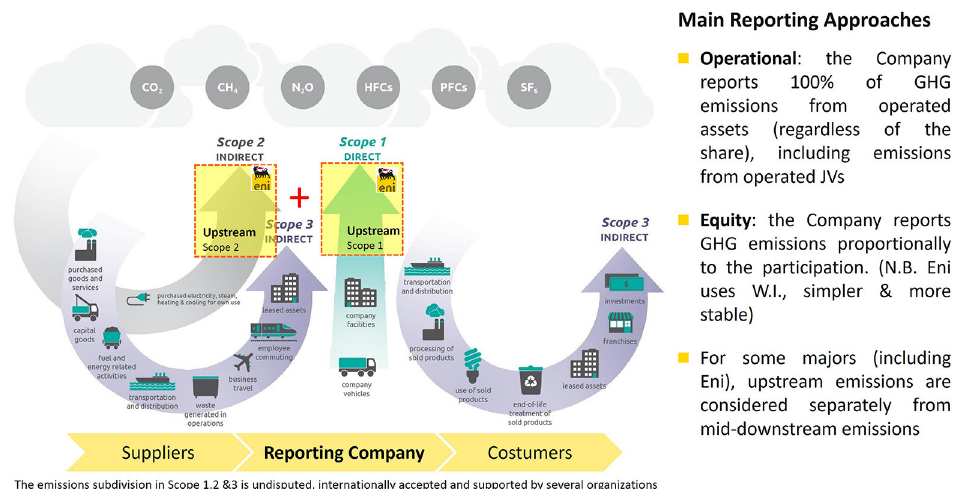
Fig. 21. – Greenhouse Gas (GHG) emissions classification, Scope 1, 2 and 3 (Source: Eni,